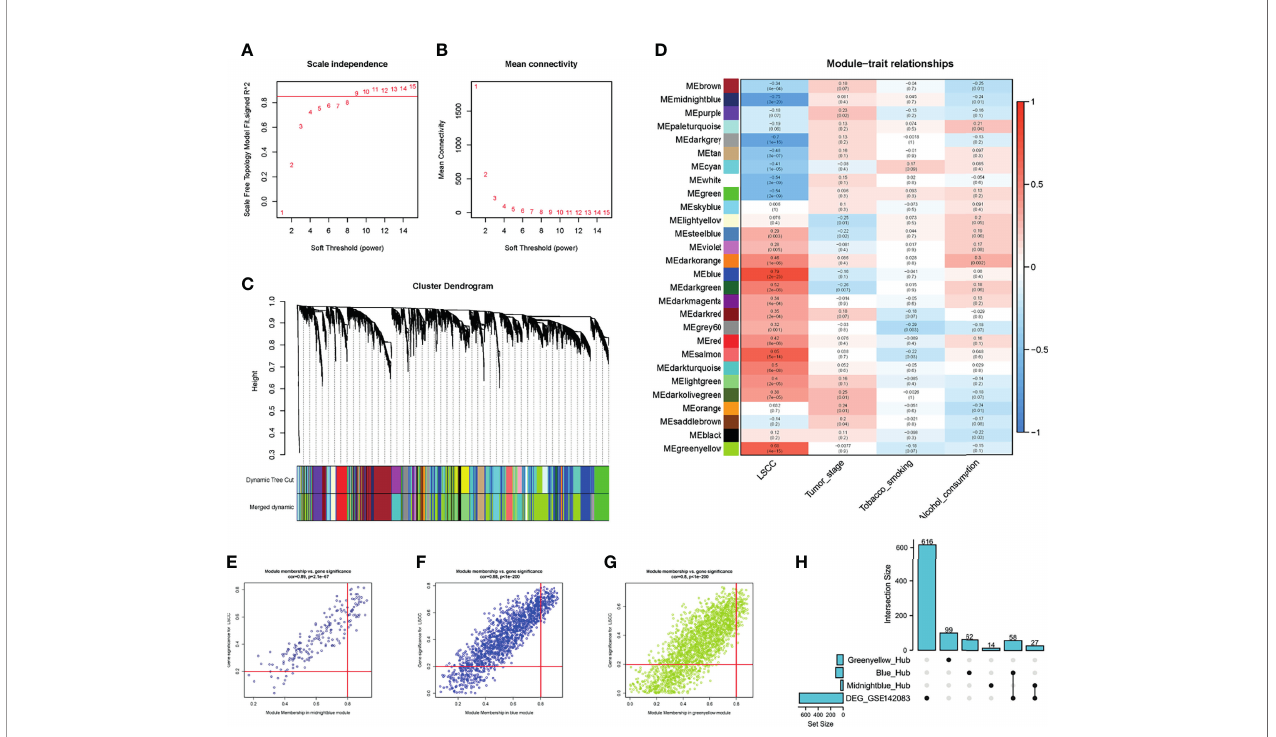
FIGURE 3 | WGCNA of the LSCC samples. (A, B) Analysis of the network topology for various soft thresholding powers. (A) Scale-free fi t index (y-axis) as a function of the soft-thresholding power (x-axis). Horizontal red line shows x = 0.85. (B) Mean connectivity (degree, y-axis) as a function of the soft-thresholding power (x-axis). The power was set as 9 for further analysis. (C) Hierarchical cluster analysis was performed to detect co-expression clusters with corresponding color assignments. Each color represents a module in the constructed gene co-expression network by WGCNA. (D) Module – trait relationships. Each row represents a color module, and every column represents a clinical trait. Each cell contains the corresponding correlation and p -value. (E – G) A scatter plot of GS for LSCC versus the MM in the (E) midnight blue module, (F) blue module, and (G) green-yellow module. (H) UpSet plot for the DEGs in GSE142083 and hub genes from WGCNA. Vertical red line shows the | MM | = 0.8; horizontal red line shows the | GS | = 0.2. WGCNA, weighted gene co-expression network analysis; LSCC, lung squamous cell carcinoma; GS, gene signi fi cance; MM, module